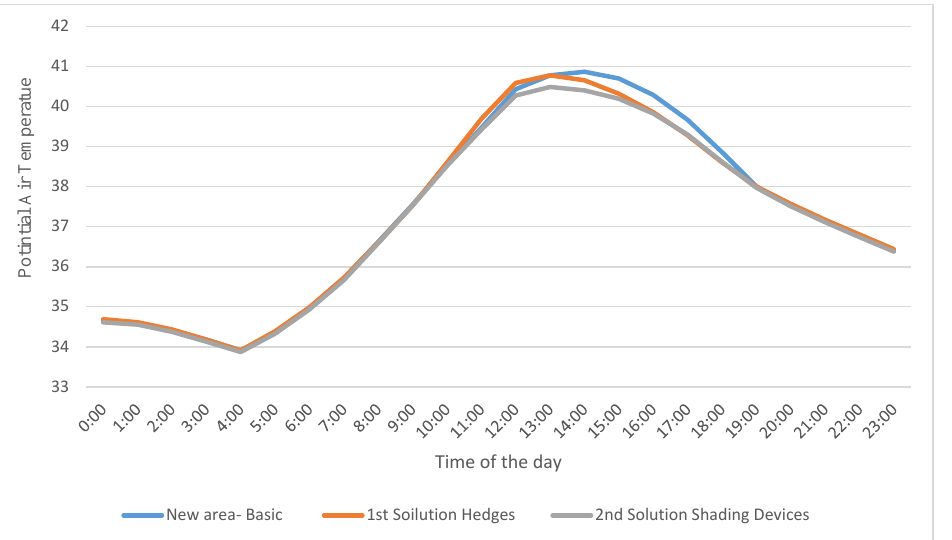
Figure 9. Average potential air temperature for the base case and the solutions at 12:00 pm on 21st of August at height 1.8 m. Table 6. Average potential air temperature for the base case and the solutions at 12:00 pm on 21st of August at height 1.8 m. Time New Area-Basic